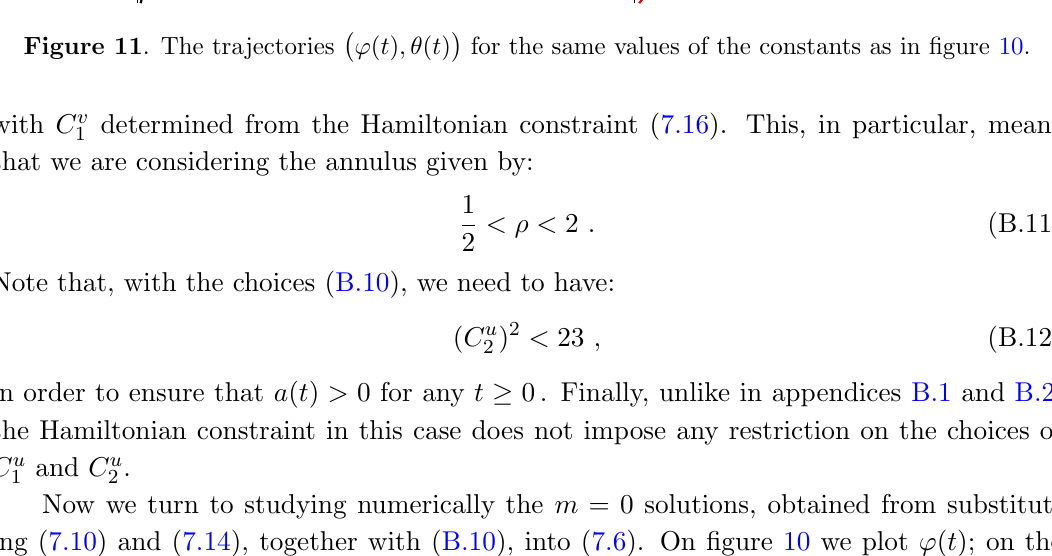
Figure 11 . The trajectories